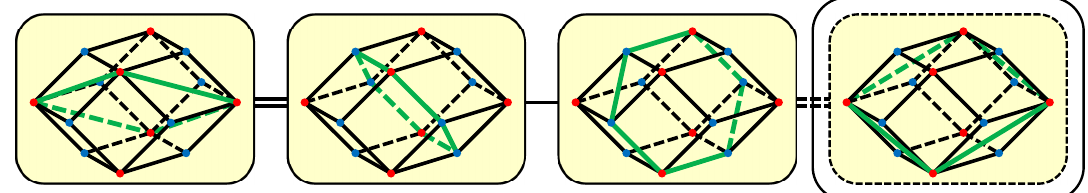
Figure 3 . Symmetries of the fundamental domain of duality cascades. Symmetries are understood by the B Weyl group generated from Weyl reflections s 3 the metric may not be orthonormal. Each transformation is given explicitly in appendix A.1. The rightmost reflection s is neither independent nor affine; it is just obtained naturally by folding 50 the affine Dynkin diagram of D 5